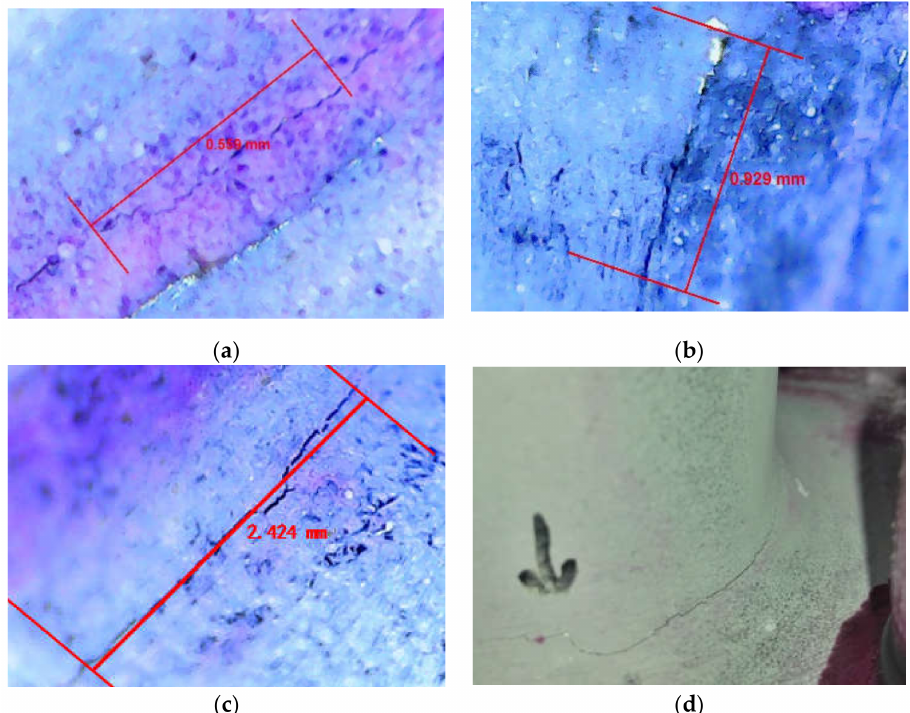
Figure 9. Microscopic observation of fatigue crack in T-type tube-plate joint ( a ) observed crack of 0.559 mm length ( b ) observed crack of 0.929 mm length ( c ) observed crack of 2.424 mm length ( d ) cracks initiated at edges of the base metal.